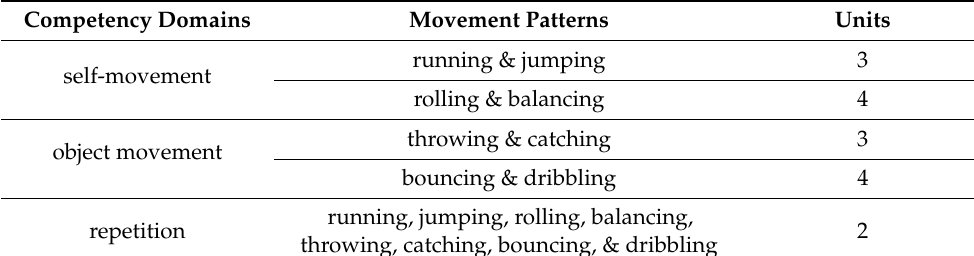
Table 1. Scope and movement patterns of the